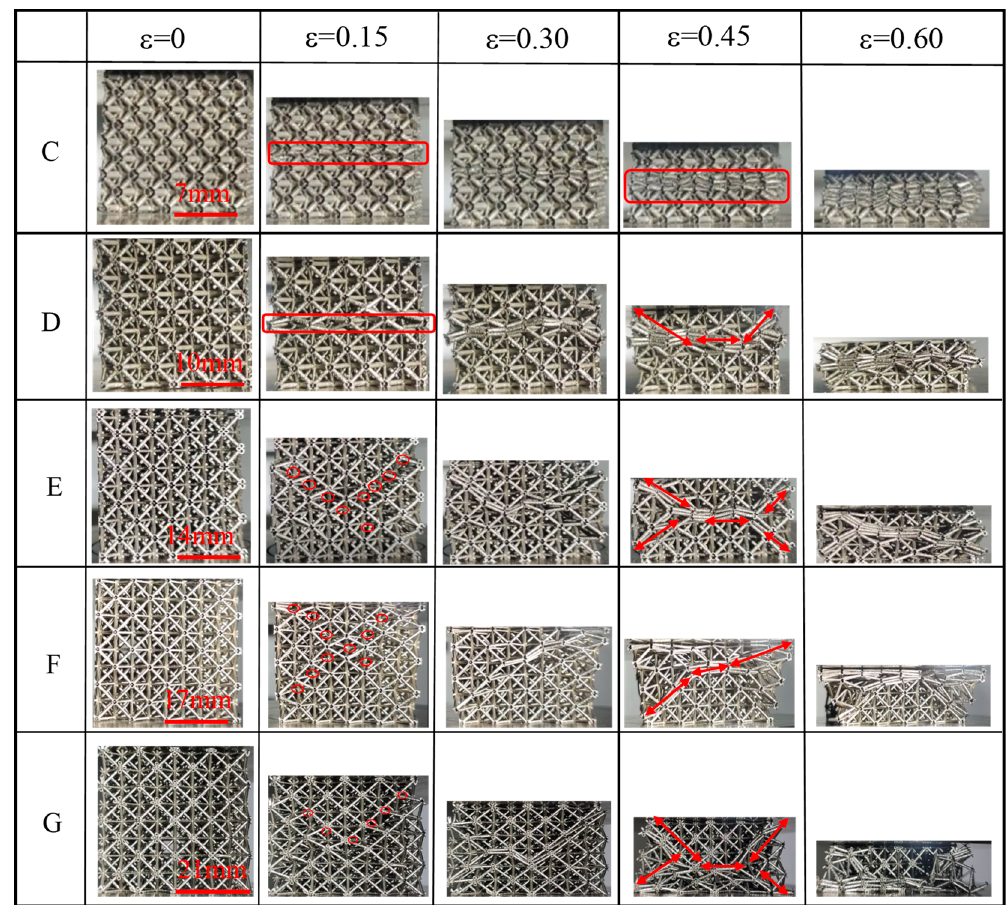
Figure 6. Quasi-static compression deformation process of the lattice with different rod diameters of the same length.